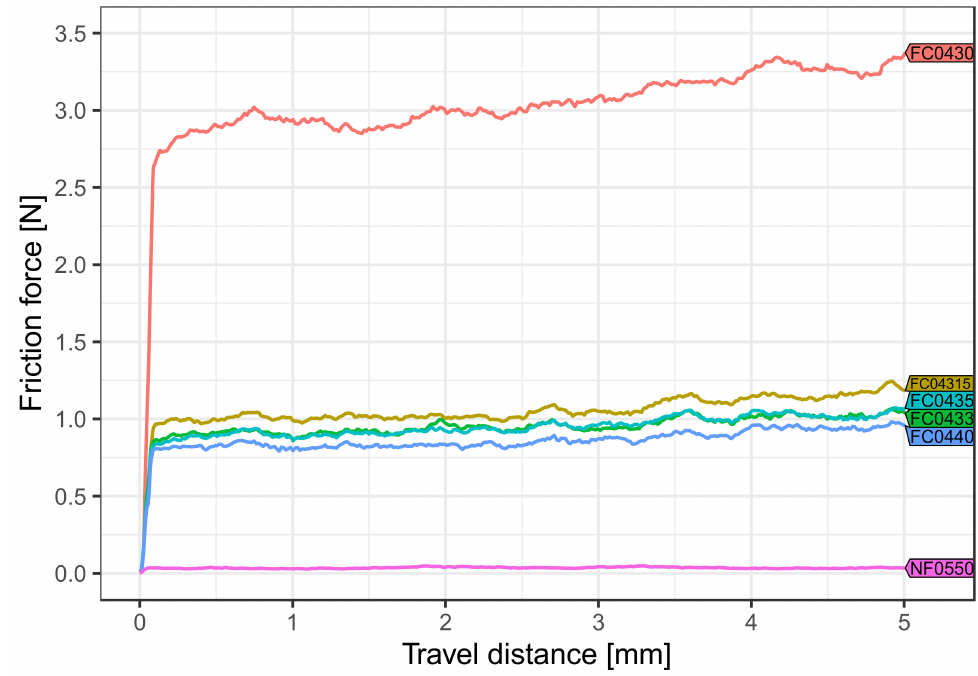
Figure 5. Effect of artificial saliva at room temperature. Whereas a low amount of frictional force occurred with covering NF0550, different friction force values were shown depending on the design. Only